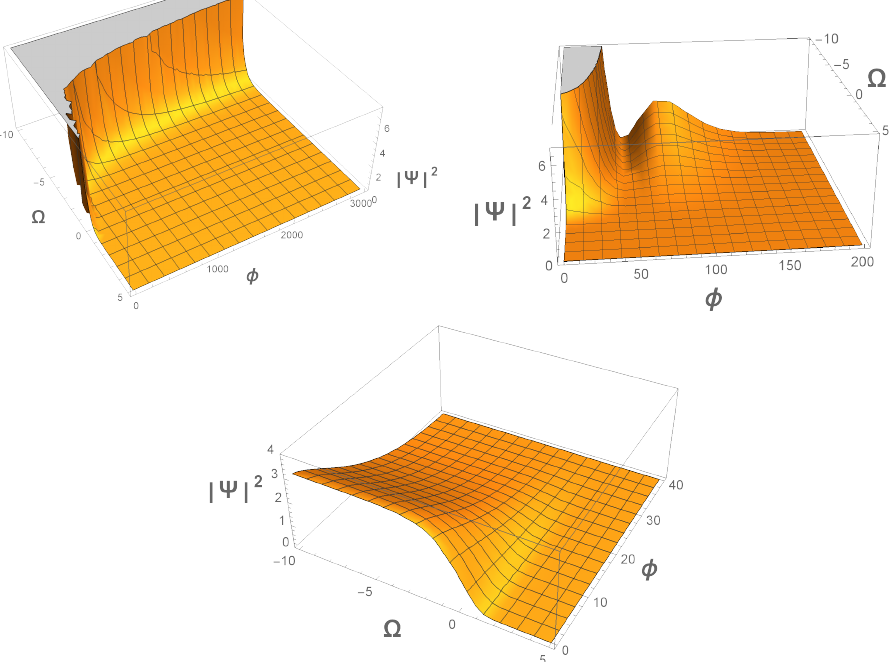
Figure 1. In the radiation era, we plot the Equation (47), considering different values in the order parameter Q = − 1,1,0, from top to bottom, respectively. We consider the value for the parameter µ = 0.5; we discard other values in the Q